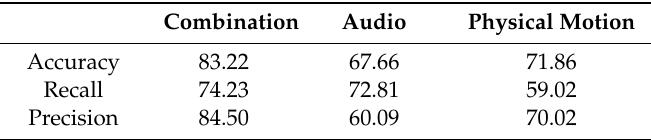
Table 5. Performance of inter-individual classification (%) using multimodal (combination of audio and physical motion) and unimodal